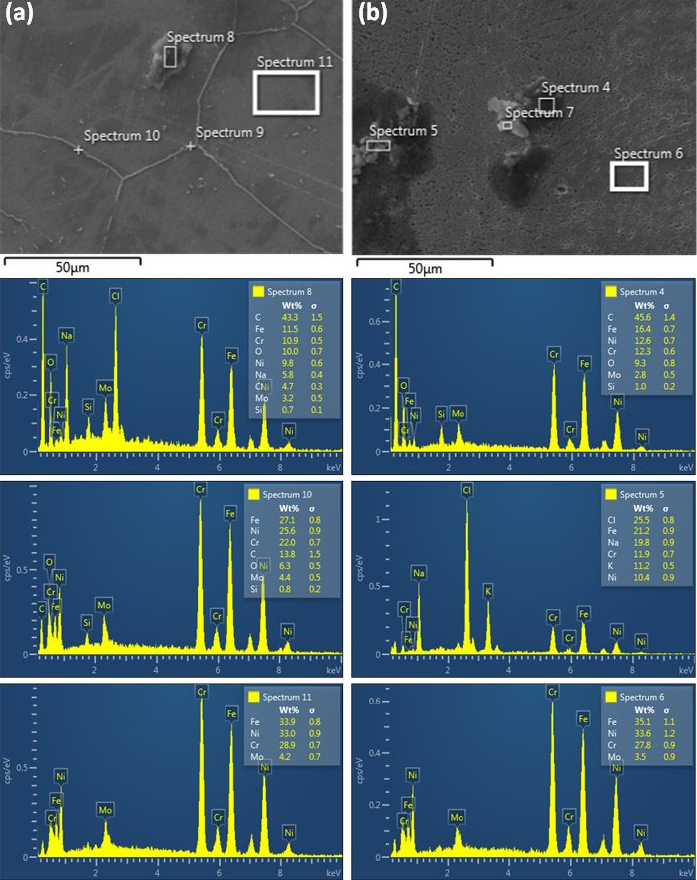
Figure 13. Typical EDS analysis of the corroded surface for samples ( a ) AT11 and ( b ) T30